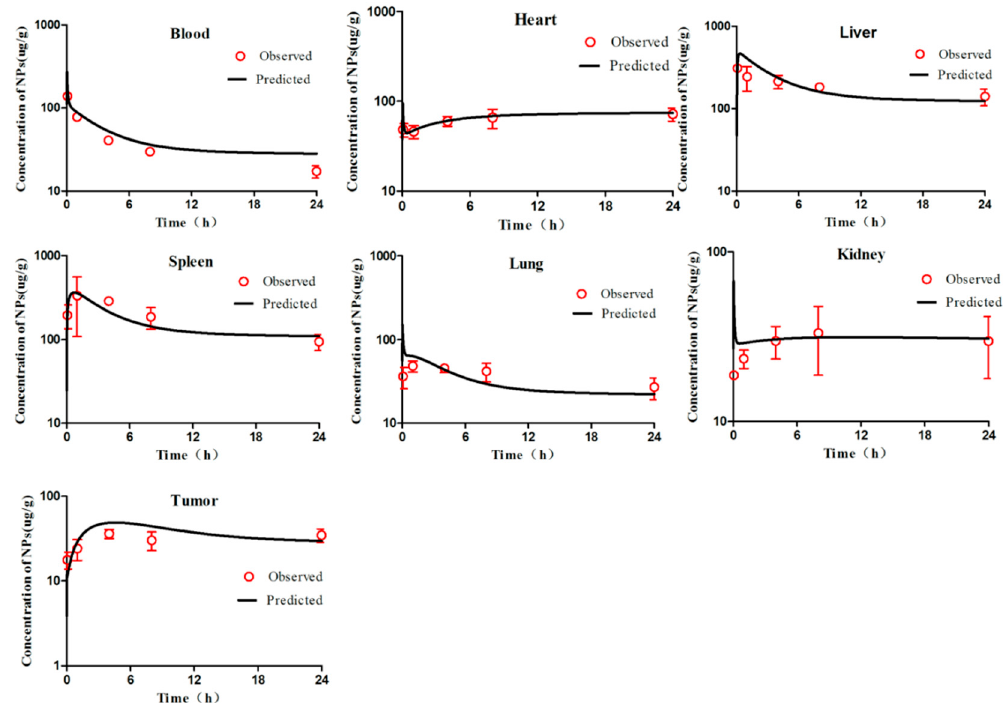
Figure 2. Simulated and experimentally measured concentration–time curves of mPEG5k-9.09%-80 nm NPs in murine blood and tissues after intravenous injection. Simulation results are represented by solid lines in each panel, and the mean values of measured data are represented by red dots. Error bars represent standard deviation of experimentally measured data.